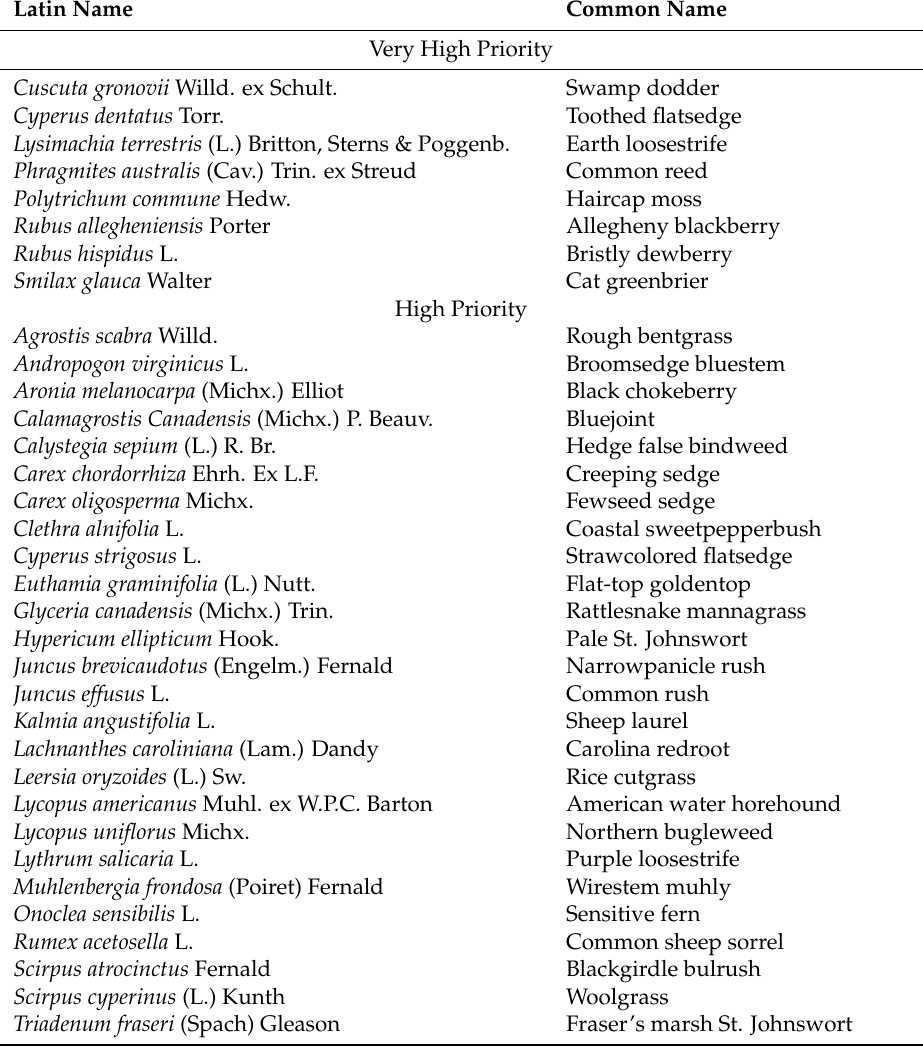
Table 2. Listing of very high and high priority weed species for North American cranberry production, based on Sandler et al., 2015 and Neron et al.,